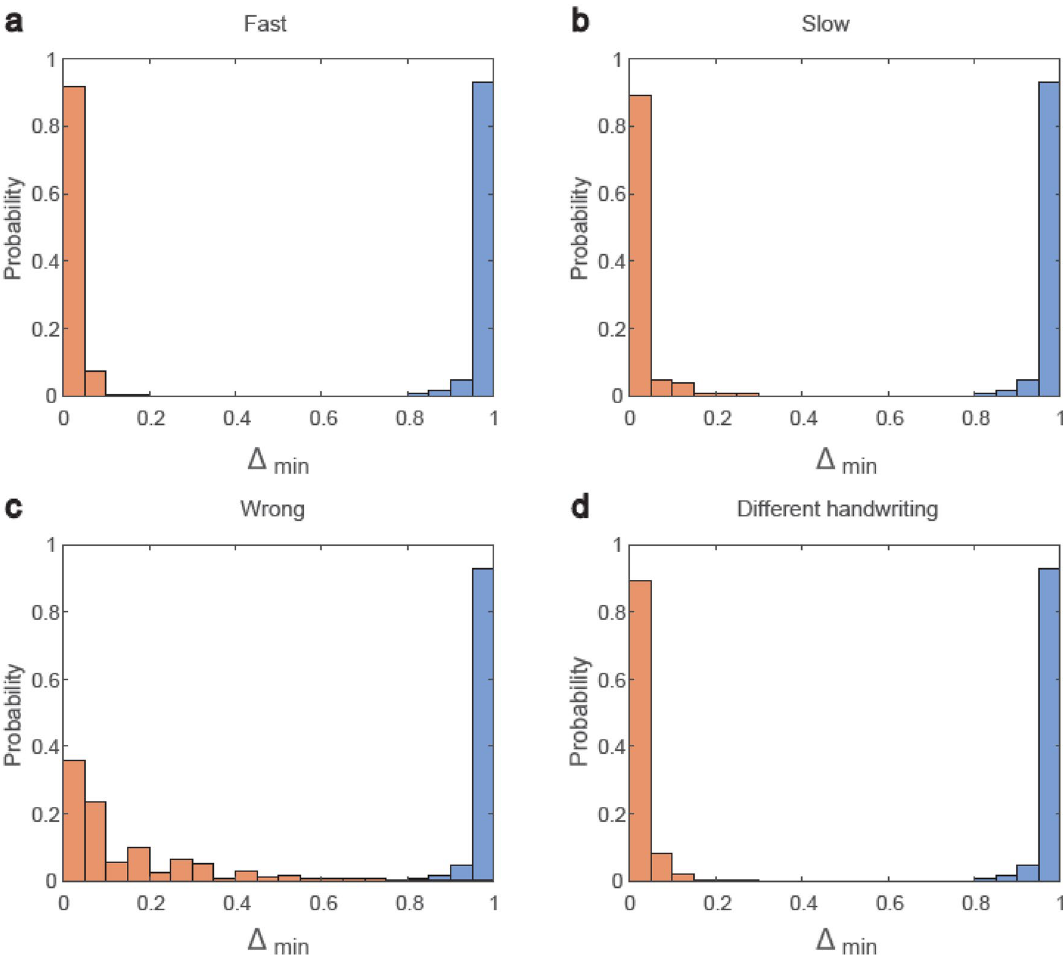
Figure 3. ID-net for writer-dependent recognition. ID-net (Fig. 1b) is trained on one individual’s handwriting, comprising a sequence of 10 different MNIST digits, with 50 additional similar synthetic sequences generated by adding integer noise in the range [− 20, 20] to pixels with a gray-level greater than 100. For each predicted test digit, the gap between the highest and second highest firing output nodes is normalized by d 1 to the range [0, 1], and its minimal value among the 10 digits (cid:31) min is selected (“Methods”). ( a ) (cid:31) min for the handwriting of one individual (blue) and for fast sequences (orange). ( b ) Similar to ( a ) with slow sequences (Fig. 1e). ( c ) Similar to ( a ) with wrong sequences (Fig. 1e), where a threshold of 0.79 results in a probability of ~ 0.993 for the accurate classification of input sequences. ( d ) Similar to ( a ) with the handwriting of different individuals taken from MNIST. A gap is evident between the blue and orange